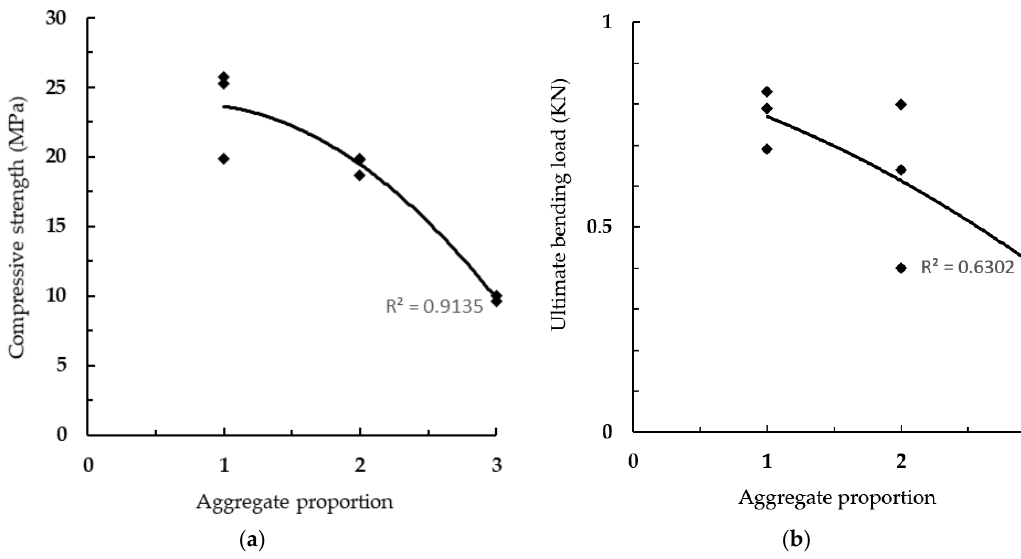
Figure 10. Strength and load evolution depending on the recycled aggregate proportion. ( a ) Figure10. Strengthandloadevolutiondependingontherecycledaggregateproportion. ( a )compressive compressive strength; ( b ) ultimate bending load. strength; ( b ) ultimate bending